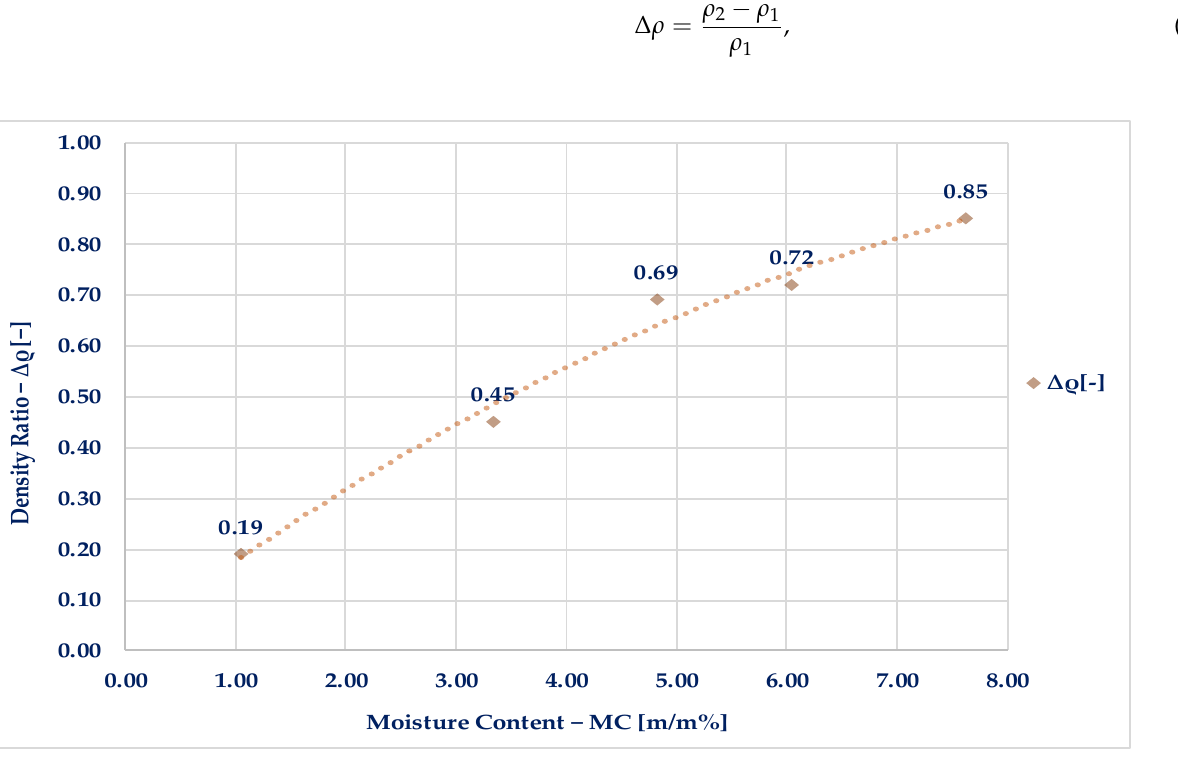
Figure 6. The change in the density ratio (before and after Bevameter test) of sandy loam soil with moisture.